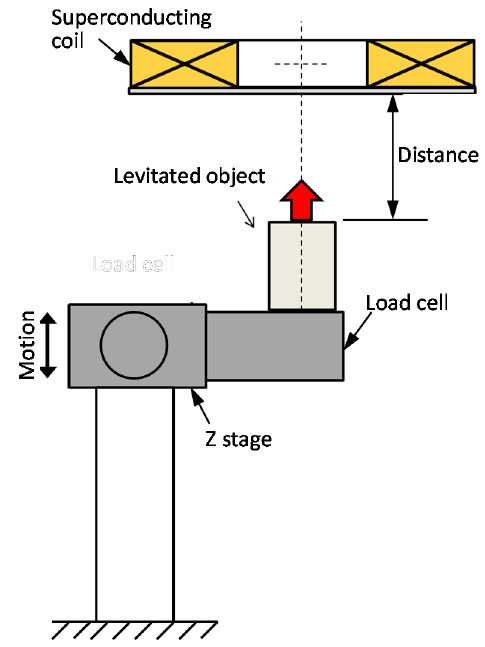
Figure 5. Experimental setup for measuring attractive forces between a superconducting coil and the suspended object.